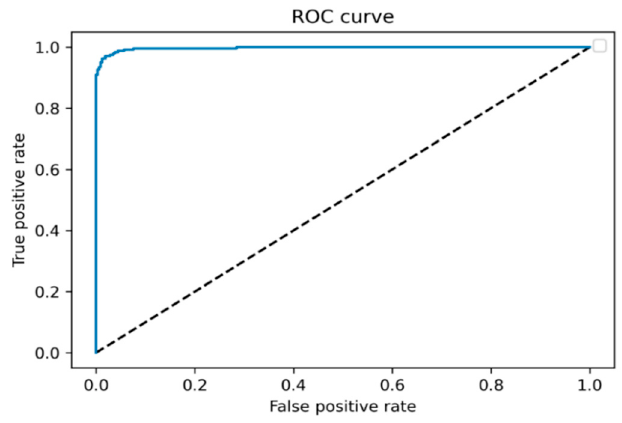
Figure 9. ROC curve when classifying BCC versus